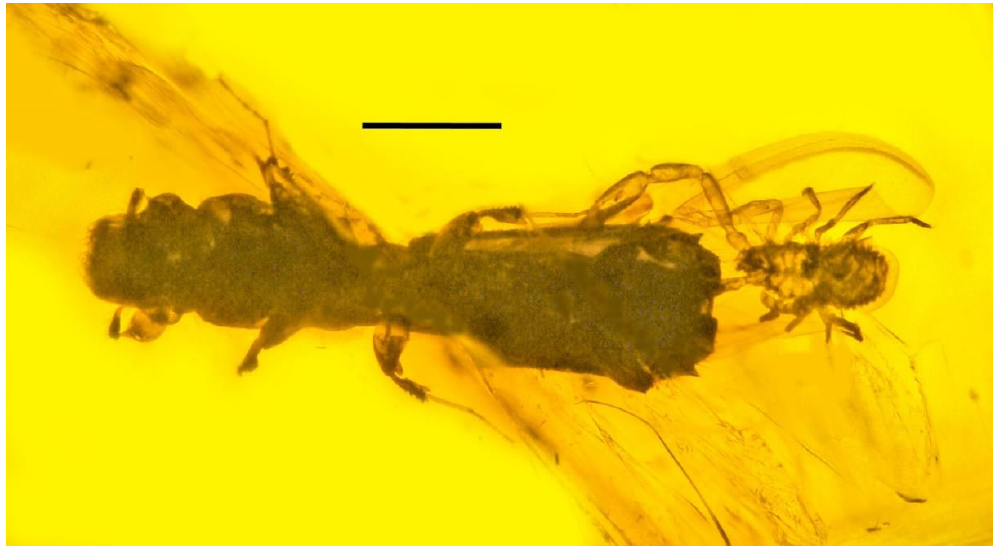
Figure 9. Adult pseudoscorpion (Arachnida: Pseudoscorpiones) clasping a platypodine beetle (Coleoptera: Curculionidae: Platypodinae) with both chelae in Dominican amber. Scale bar = 950 µm.